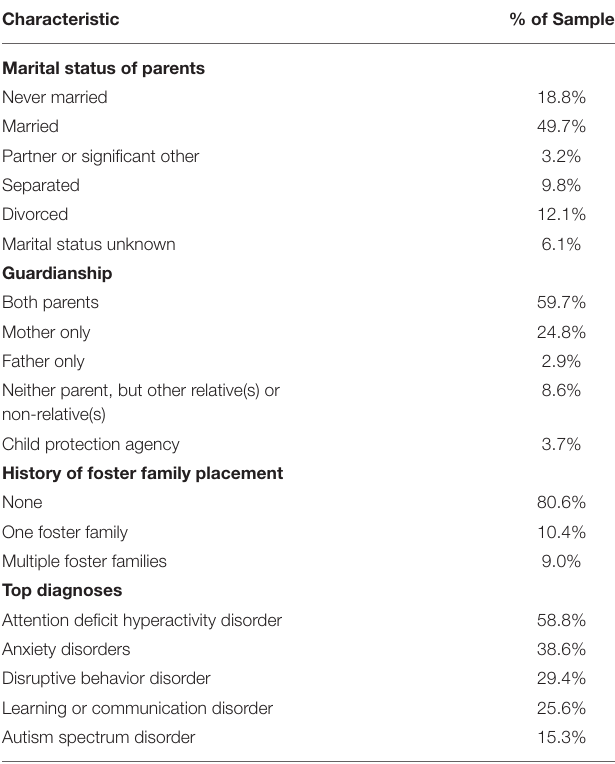
TABLE 1 | Selected characteristics of sample